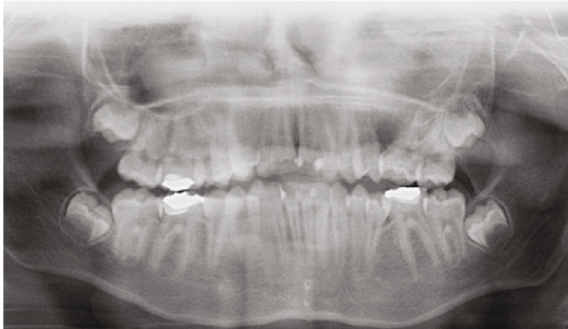
Figure 10: Postoperative 6-month follow-up.